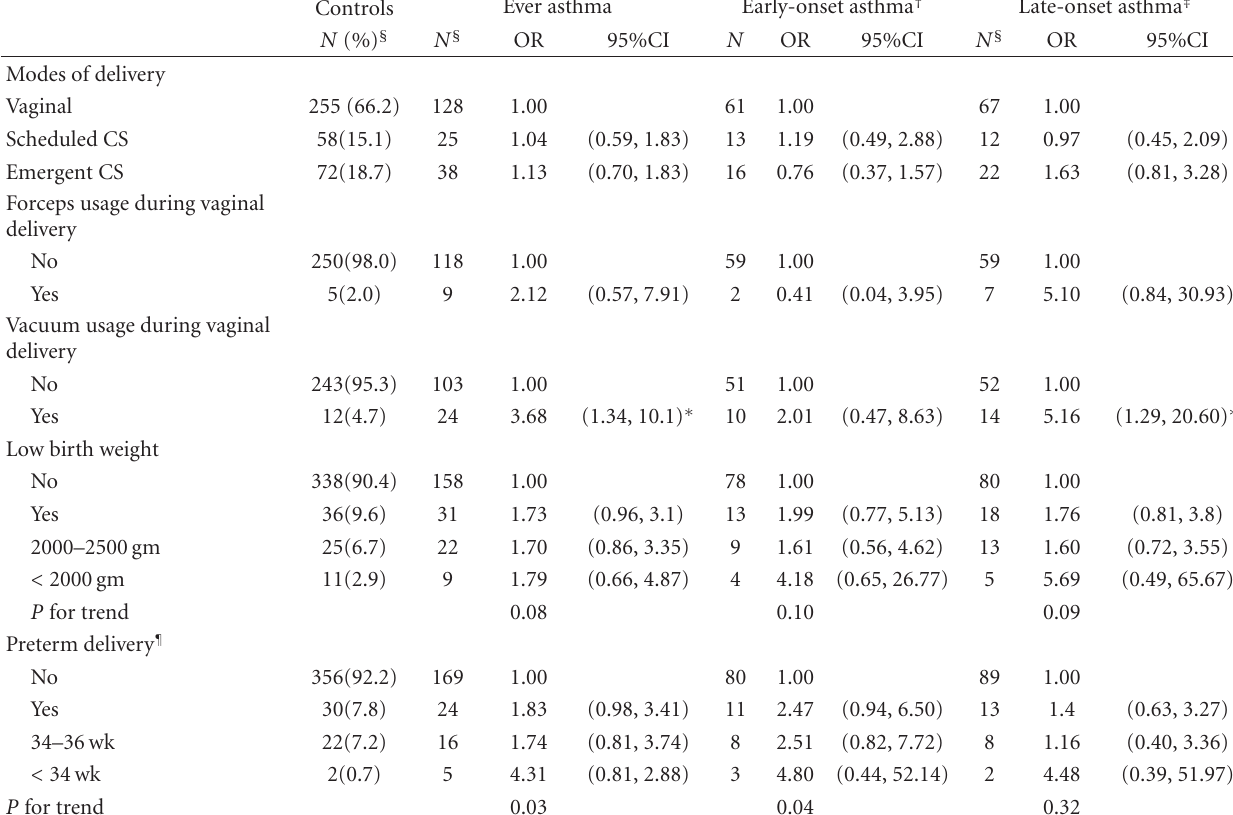
Table 3: Risks for childhood asthma in relation to delivery modes and birth